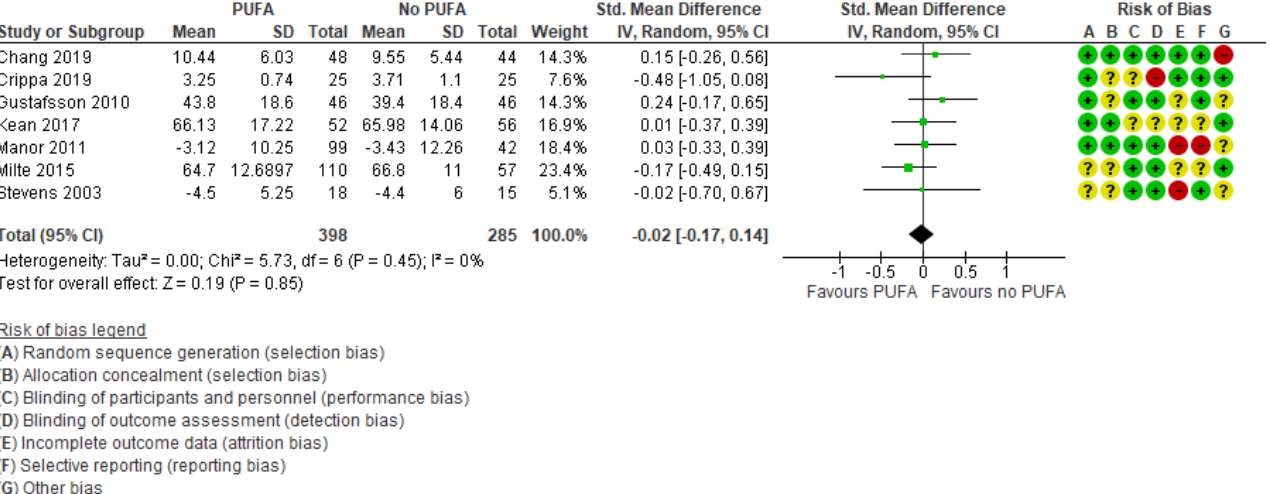
Figure 5. Forest plot of comparison: PUFA vs. placebo, outcome: parent-reported behavioral difficulties (end of treatment). Green square indicates summary estimates of the individual studies. Black diamond indicates total summary effect estimate.